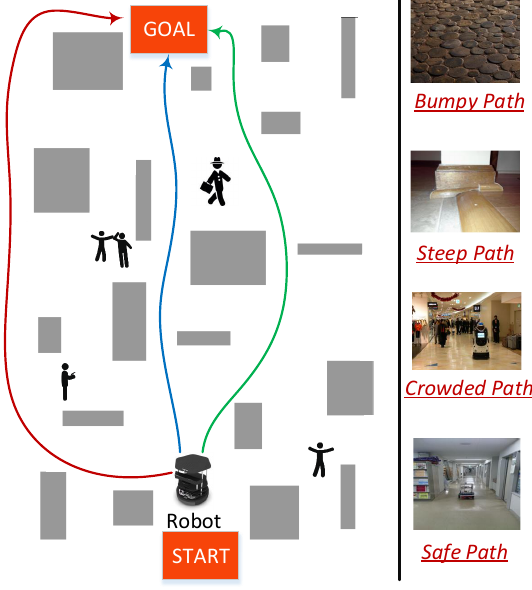
Figure 1. Selecting an optimal path from different paths based on several